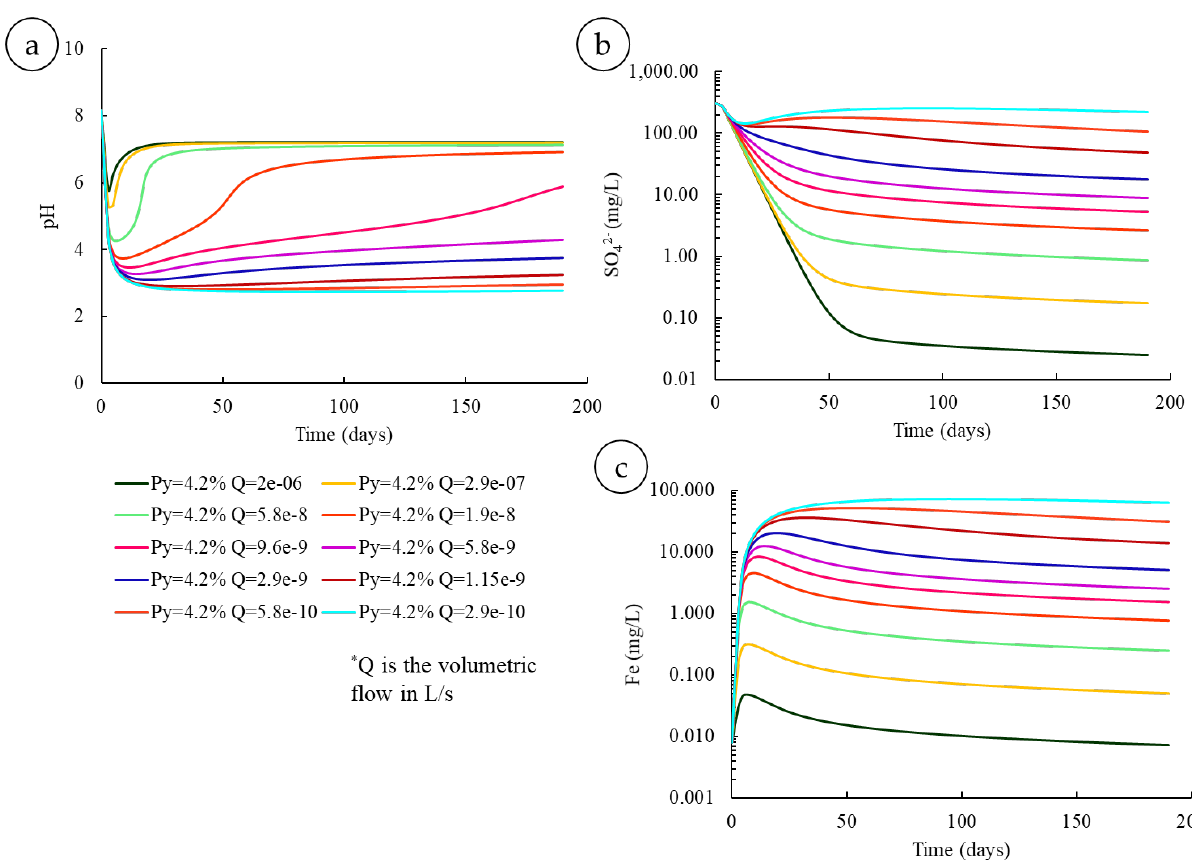
Figure 10. Various scenarios delineating the relationship between the residence time and leachate quality in weathering cell test simulation. ( a ) The pH obtained for various residence times. ( b ) Sulfate concentrations obtained for various residence times. ( c ) Sulfate concentrations obtained for various residence times.